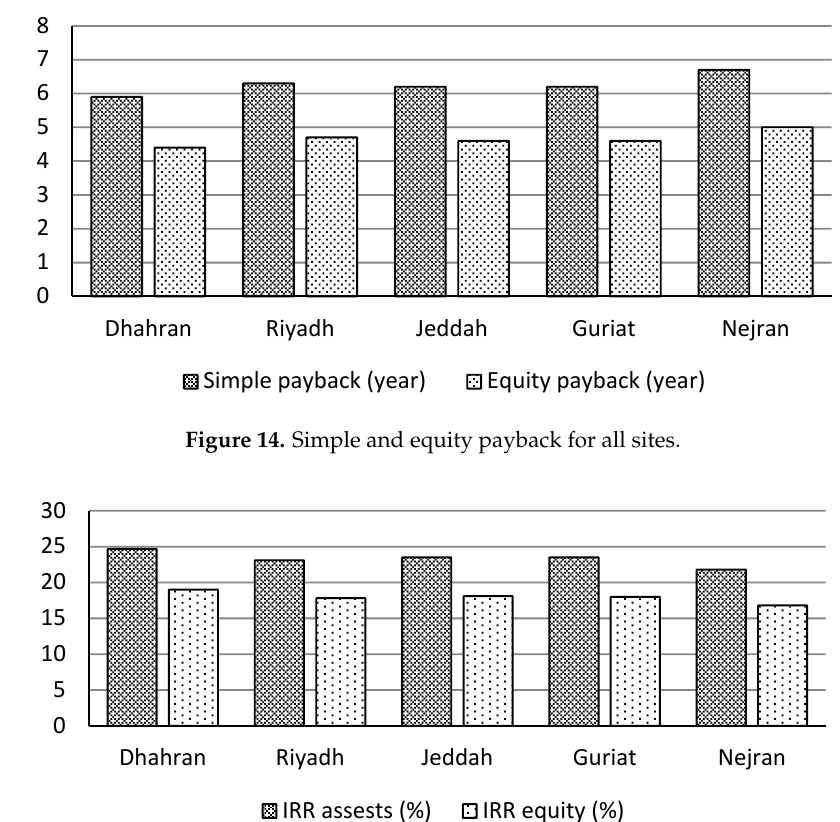
Figure 13. Cumulative cash flow for all sites.